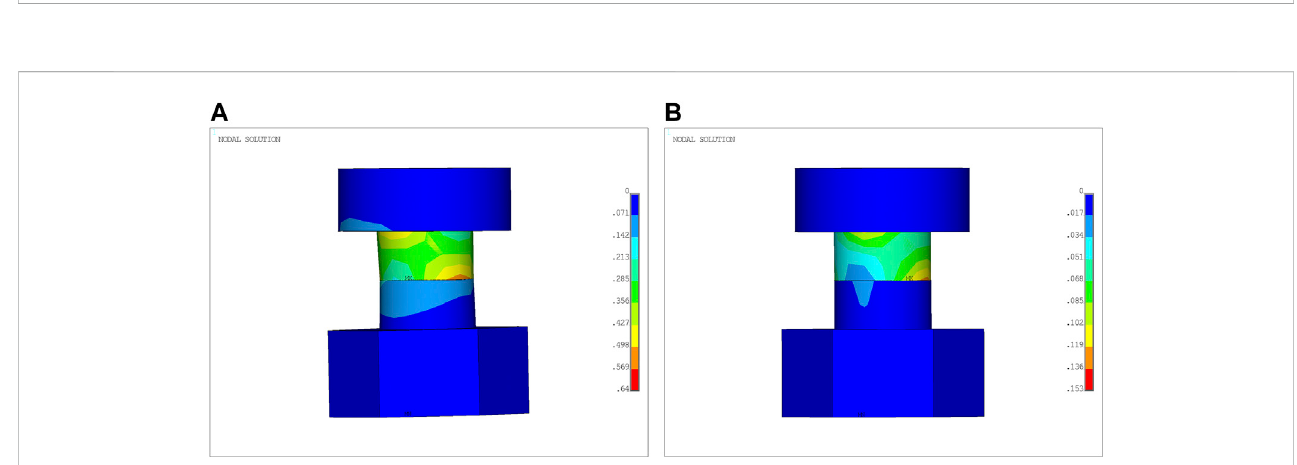
Load-displacement curves of the K-joints. (A) Case A1. (B) Case B5.